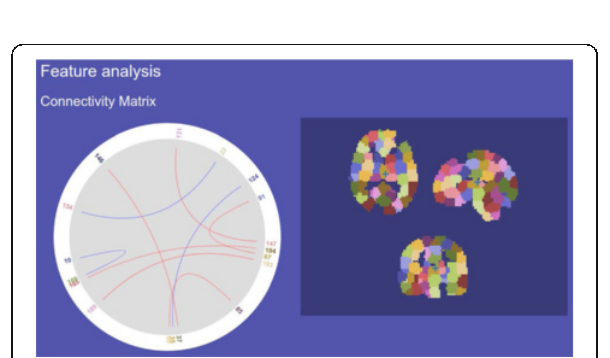
Fig. 20 (abstract A22). Deep